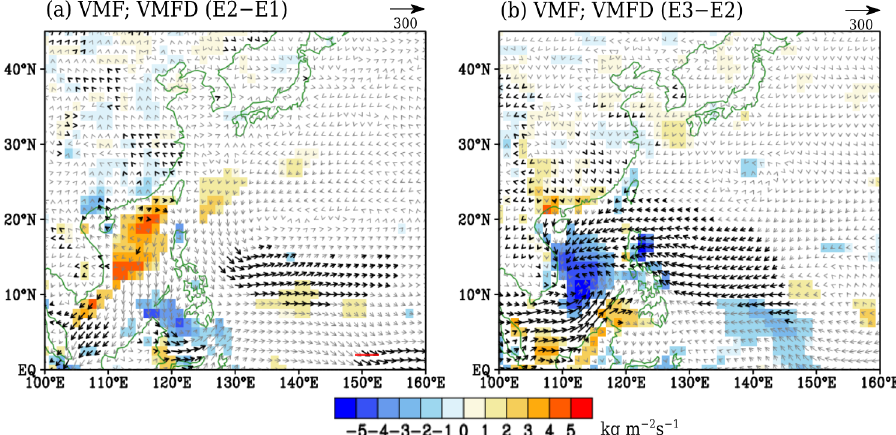
Figure 6. The epochal difference in the vertically integrated moisture flux (VMF; vectors; kg m − 1 s − 1 ) and moisture flux divergence (VMFD; shading; kg m − 2 s − 1 ) during December between: ( a ) E1 (1961–1976) and E2 (1977–1992) (E2 minus E1); and ( b ) E2 and E3 (1993–2008) (E3 minus E2). Shaded areas and black vectors indicate statistical significance above the 90% confidence level by t -test. The scale of the wind vectors is indicated on the upper right corner in each plot.